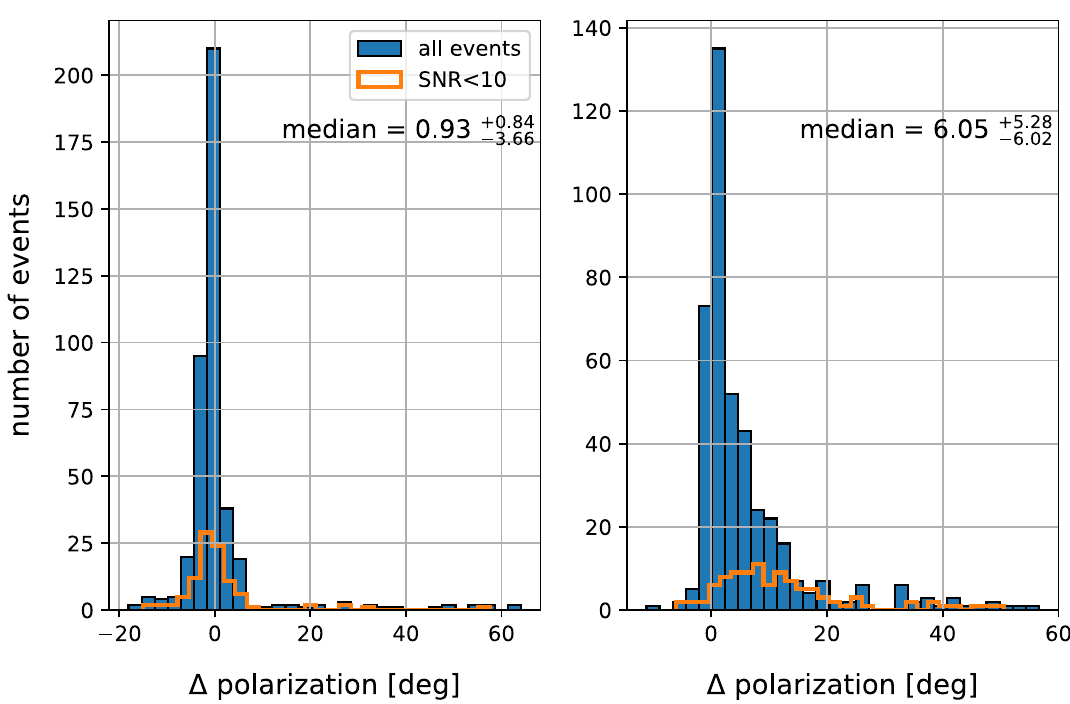
) ◦ 3 . 66 ) ◦ , with the uncertainties 6 . 02